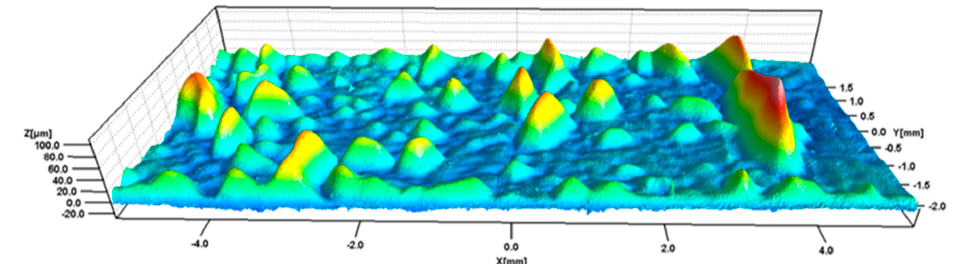
Figure 1. Blistered surface of the film insert after moulding (Z-axis scale 10:1). Moulding parameters: Mould temperature: 40 °C, barrel temperature: 200 °C.